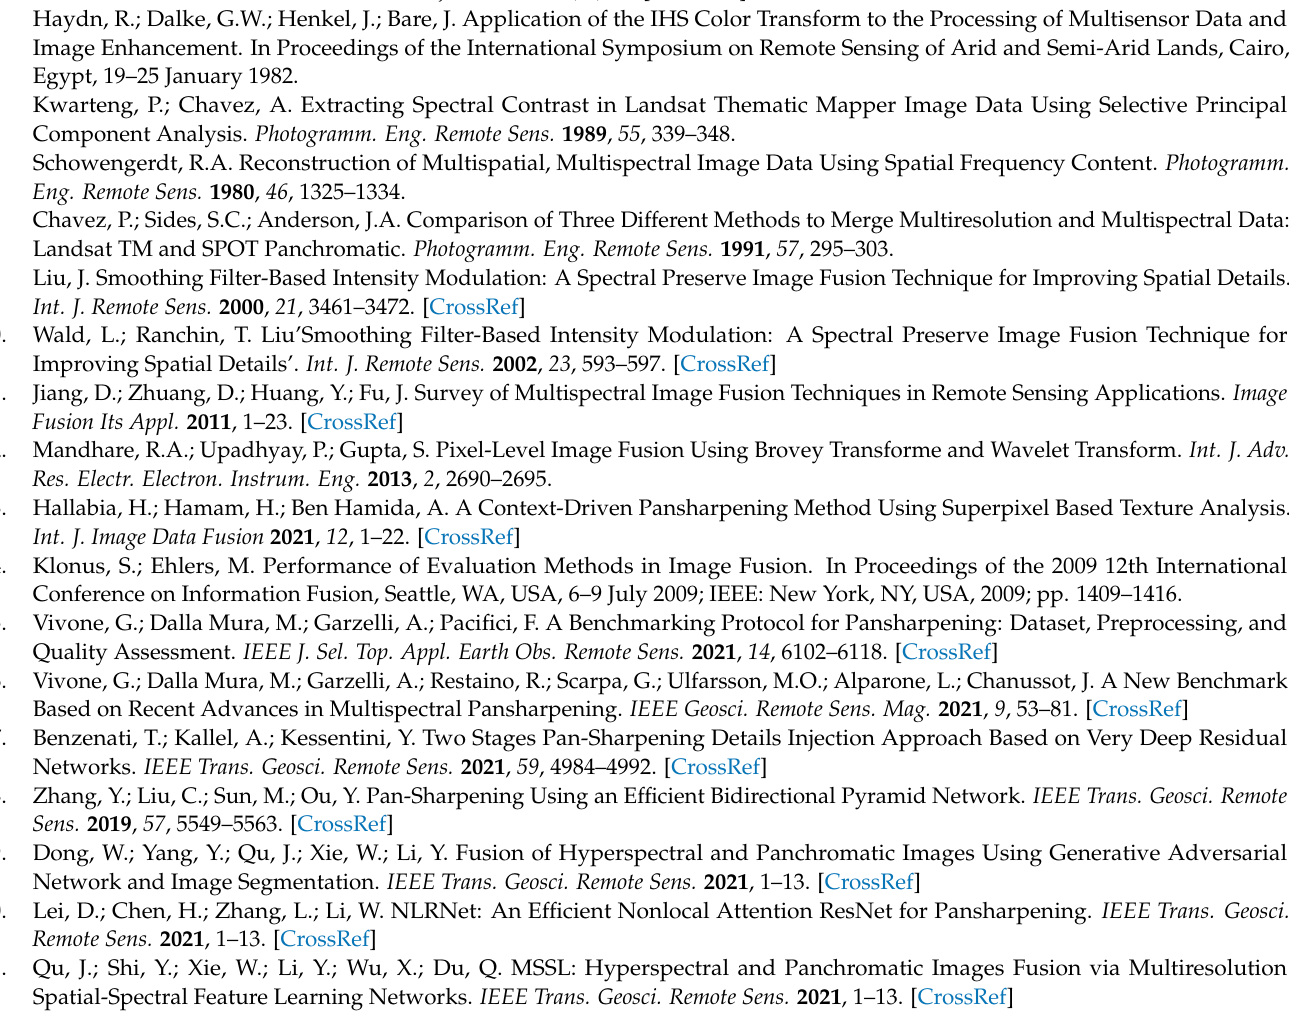
Figure A2. The registration details of the ZY1E hyperspectral image and the GF-7 panchromatic image.